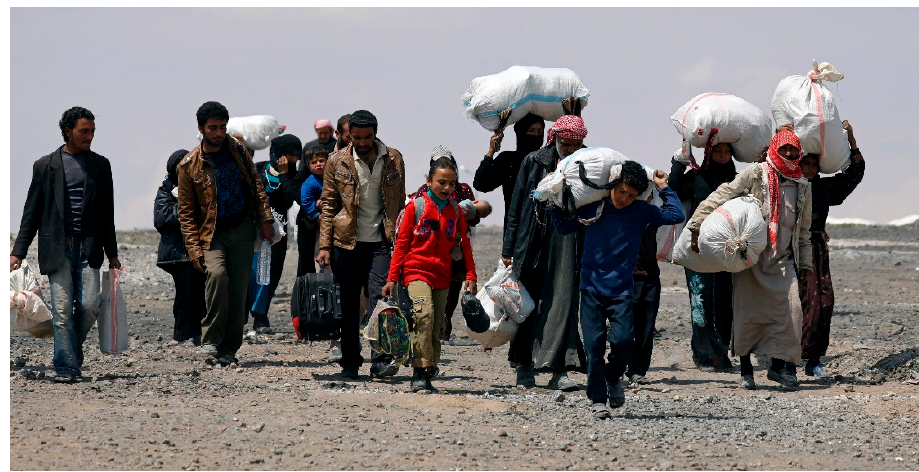
Figure 5. Syrian refugees who fled the city of Raqqa leaving a camp in Ain Issa, Raqqua Governorate, 2017, Reuters News Agency.